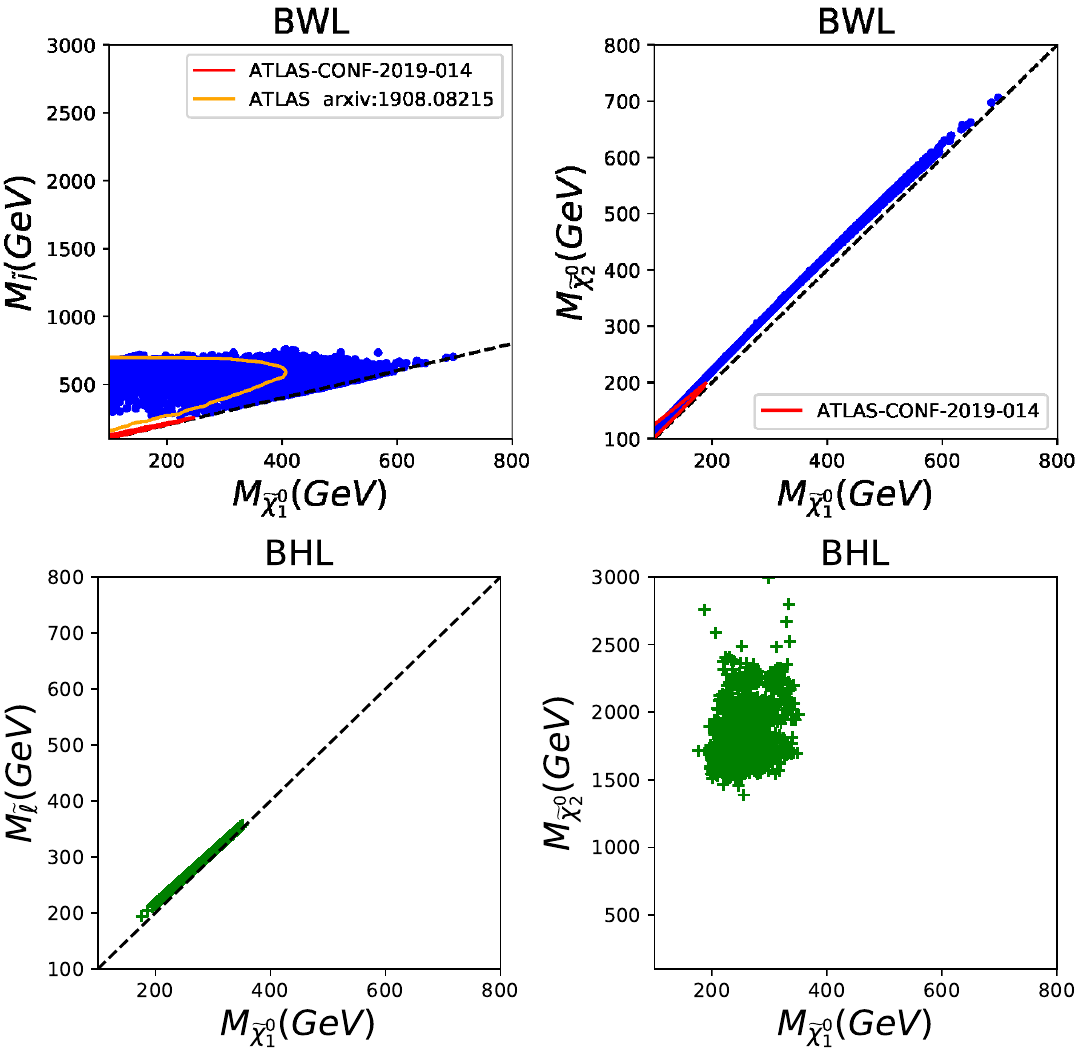
Figure 3 . Scatter plots of the samples survived the constraints (1){(5) and the current direct detection limits, displayed on the plane of M correspond to the BWL and BHL scenarios, respectively. For the BWL case the regions excluded by ATLAS [57, 58] are